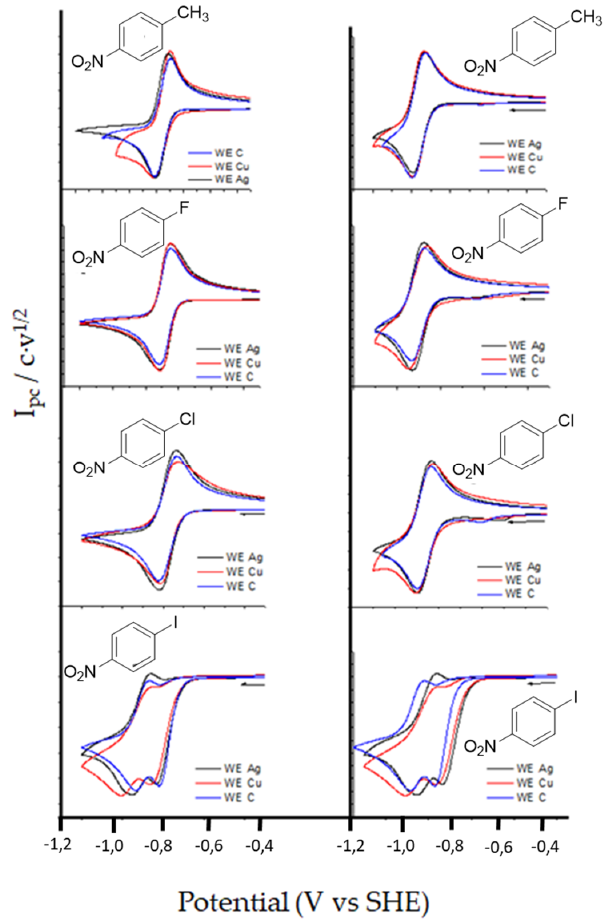
Figure 2. Cyclic voltammetry of 10 mM p -nitro compounds 1 - 4 with Ag (black line), Cu (red line) and C (blue line), under nitrogen atmosphere. Scan rate: 0.5 V · s − 1 . Solution of DMF / 0.1M TBA BF 4 (left) and solution of 3 mL EMIM TFSI